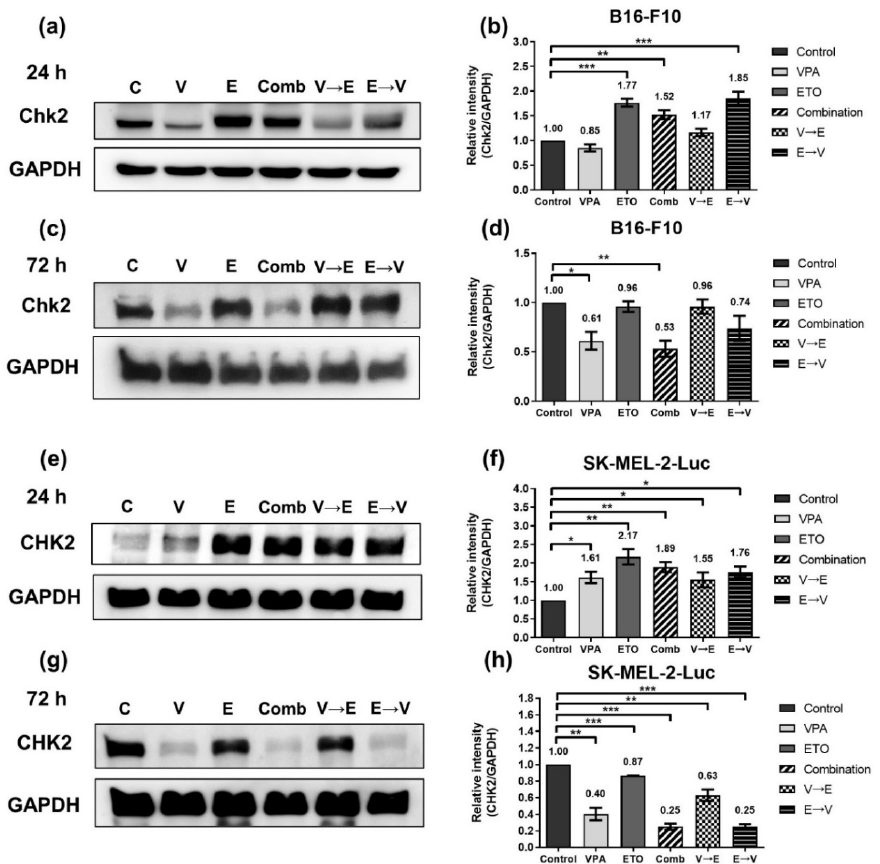
Figure 7. Expression of homologous recombination-related protein Chk2/CHK2, under single, simultaneous, and sequential combined treatments of VPA and ETO in melanoma cells. Western blot analysis illustrated the Chk2/CHK2 protein expression after ( a ) 24 h ( c ) 72 h single, simultaneous, and sequential combined treatments of VPA and ETO in B16-F10 cells. ( b , d ) was quantitative analysis of ( a , c ), respectively, which was obtained by using Image J software 1.52a (National Institutes of Health, Bethesda, MD, USA). The analysis was repeated in SK-MEL-2-Luc cells. Western blot data of ( e ) 24 h and ( g ) 72 h was shown, and the corresponding quantitative analysis was shown in ( f , h ), respectively. GAPDH was used as the control of sample loading. Relative intensities of Chk2/CHK2 to GAPDH expressions were normalized with the control. The data are shown as means ± SEM of independent experiments in triplicate. (* p < 0.05; ** p < 0.01; *** p < 0.001). The drug dosages were referred to IC 50 values as shown in Figure 2 and Table 1. As shown in Figure 7e,f, the expression levels of CHK2 under the specified treatment schemes were repeated in SK-MEL-2-Luc cells. The results also demonstrated that ETO dominated the expression level of CHK2. It is noted that the variation range of CHK2 expression levels in SK-MEL-2-Luc cells was broader than it in B16-F10 cells.